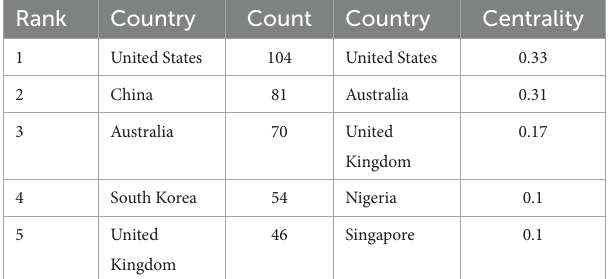
TABLE 7 Top five countries in terms of count and centrality.